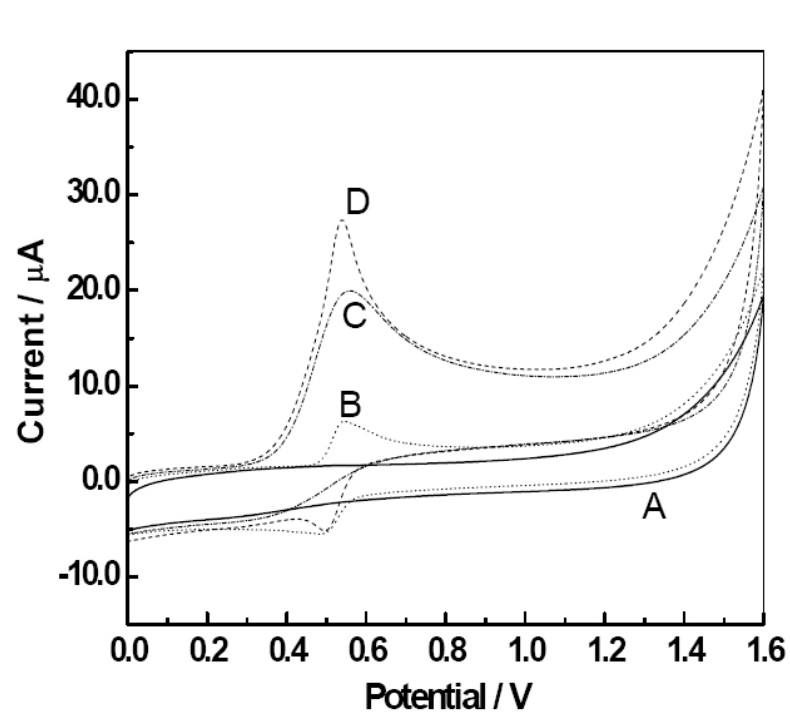
Fig. 1 CVs obtained on GC electrode in 0.1 M HclO 4 solution(A), A+ 1 × 10 − 4 M DA (B), A+1 . 0 × 10 − 3 M AA (C), and A+ 1 × 10 − 4 M DA +1 . 0 × 10 − 3 M AA (D) ; (Sweep rates 0.1 V s − 1 ).